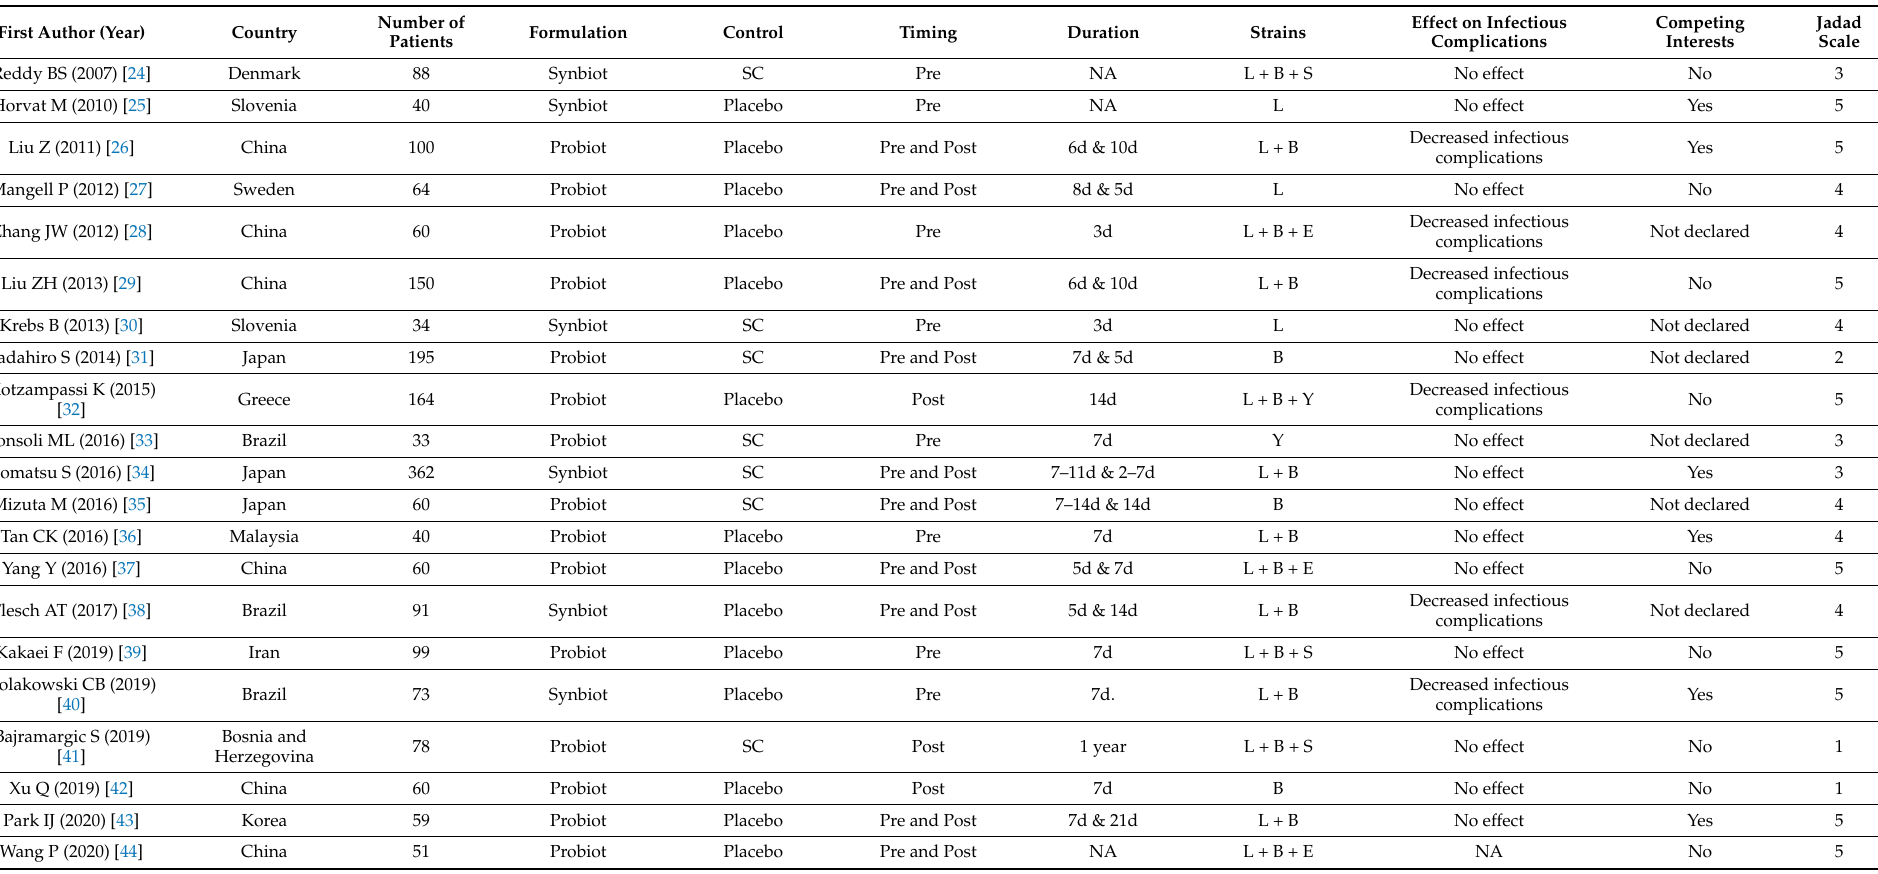
Table 1. Characteristics of the included randomised trials